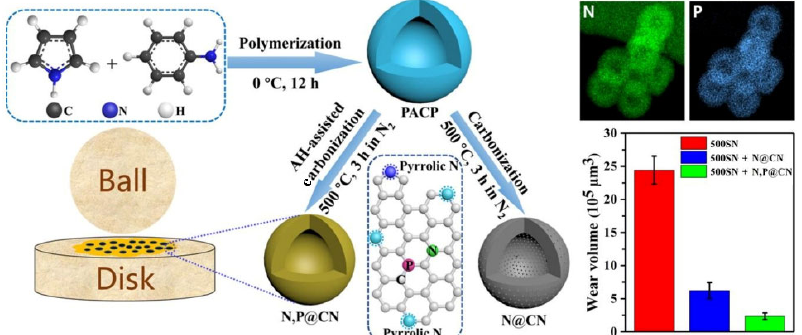
Fig. 6 Nitrogen and phosphorus co-doped CSs (denoted as CN) were prepared via the carbonization of poly (aniline-co-pyrrole) (PACP), and the prepared CSs with N, P elements showed enhanced anti-wear and friction-reducing performance as 500SN additives. Reproduced with permission from Ref. [83], © American Chemical Society